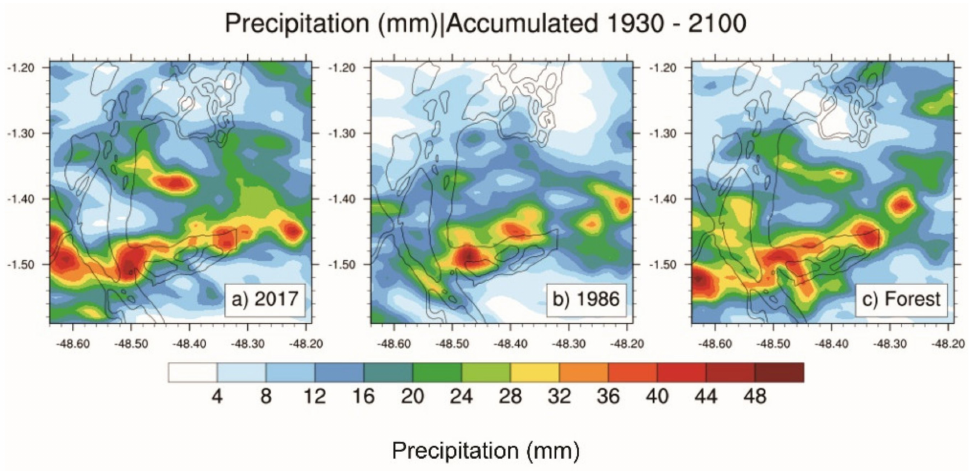
Figure 8. Total accumulated precipitations between 1930 and 2100 UTC.